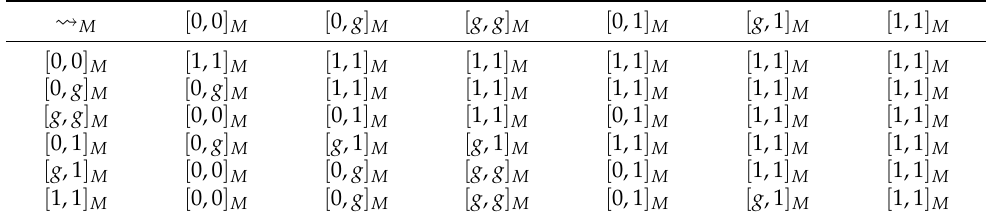
Table 9. The operation (cid:32) M of algebra in Example